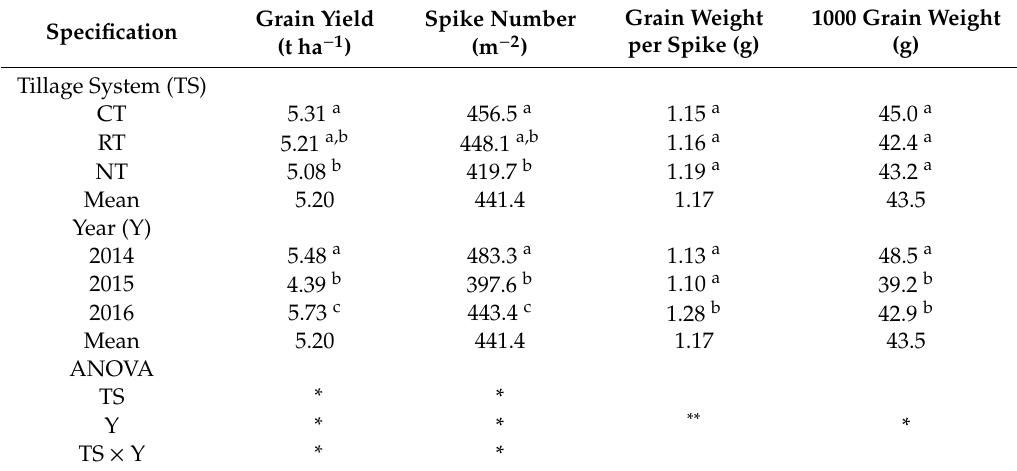
Table 1. Grain yield of winter wheat and its